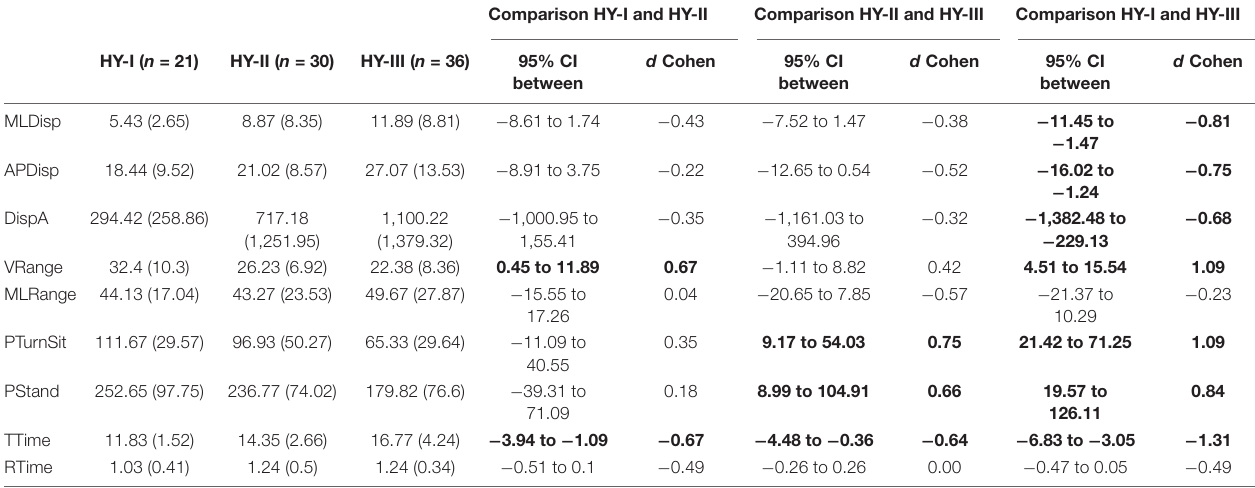
TABLE 2 | Differences between balance, gait, and risk of falls for different PD